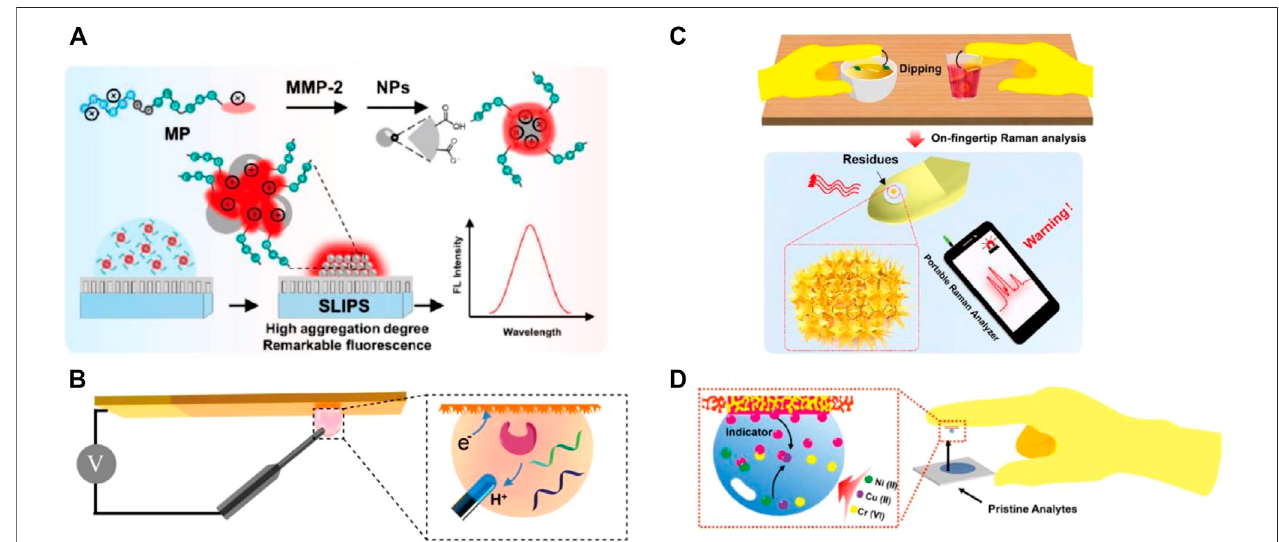
FIGURE2|(A) Sensingprocessofpeptide-conjugatedAIEgenforquantitativedetectionofMMP-2secretedfromcellsontheslipperysurface(Wuetal.,2021). (B) SuperwettableelectrochemicalmicrochiptowardPSAdetection(Xuetal.,2018). (C) Tape-basedSERSsuperwettablesensorsforthedetectionoffoodcontaminantsin an on-hand way (He et al., 2020b). (D) Design of the superwettable tapes for the colorimetric monitoring of heavy metals (He et al., 2018).